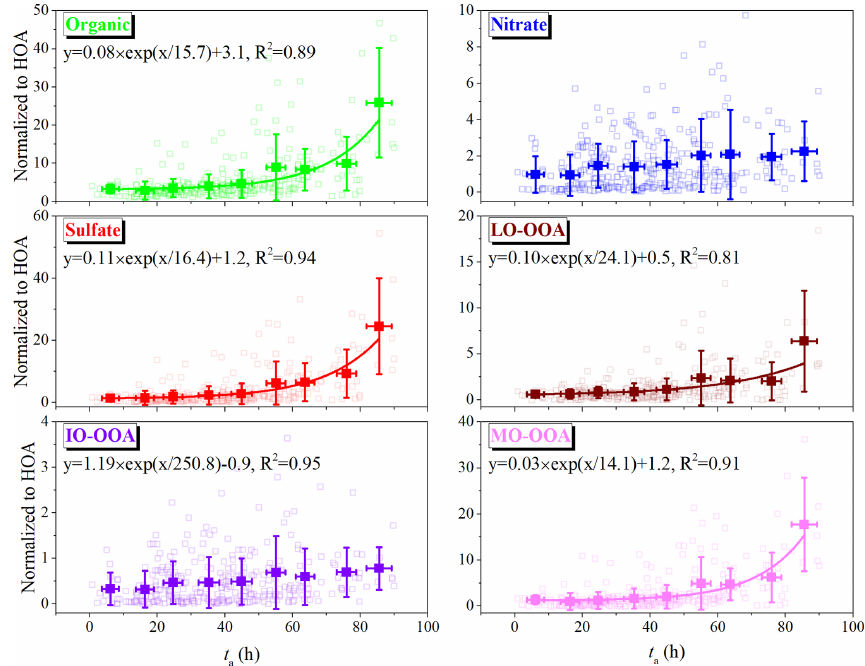
Figure 4. Variations of the ratios of mass concentrations of NR-PM 1 species and OA factors to HOA as a function of t a . The data are binned according to the value of t a (10h increments). The solid lines are the results of exponential fitting with the function of y = A · exp (x/B) + C